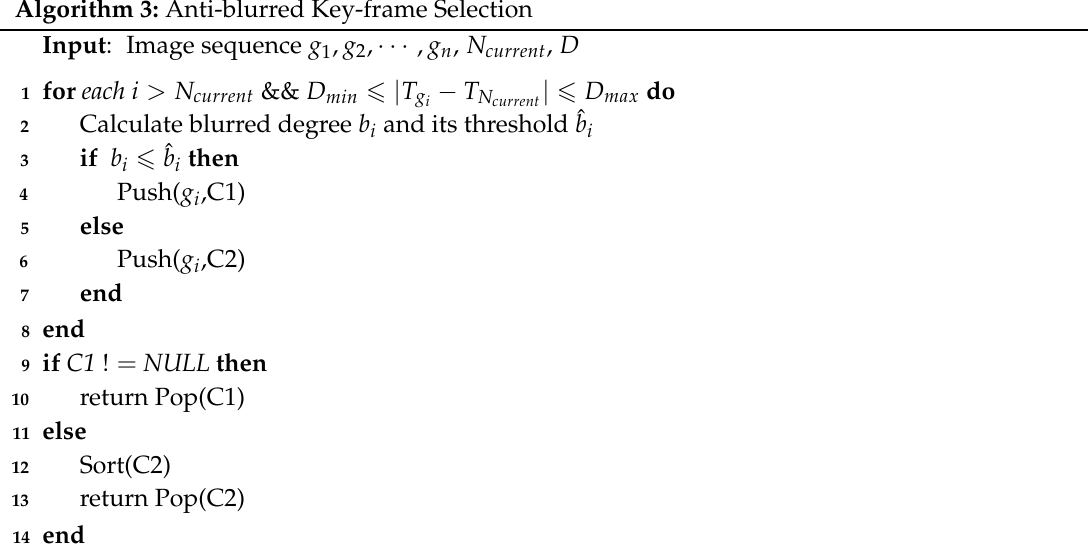
Algorithm 3: Anti-blurred Key-frame